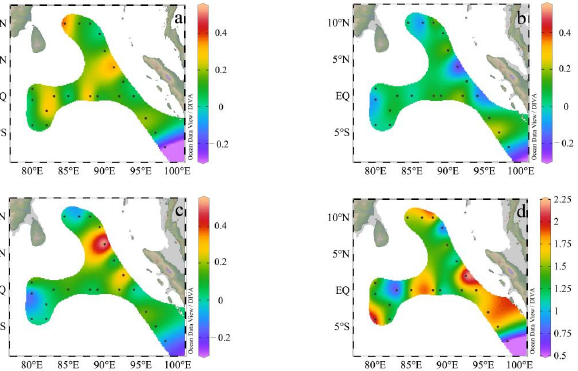
Figure 5. Distribution of sinking rates in the eastern Indian Ocean in spring 2017. ( a ) Horizontal distribution of sinking rates in 3 m. ( b ) Horizontal distribution of sinking rates in 75 m. ( c ) Horizontal distribution of sinking rates in 100 m. ( d ) Horizontal distribution of sinking rates in 200 m.